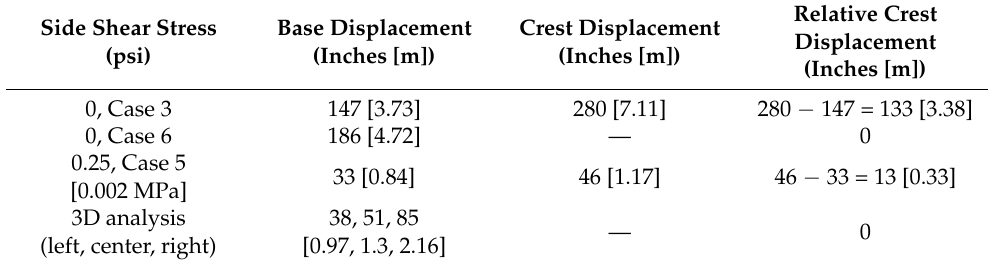
Table 11. Permanent displacements for the SRCH10-50k Earthquake, long-term